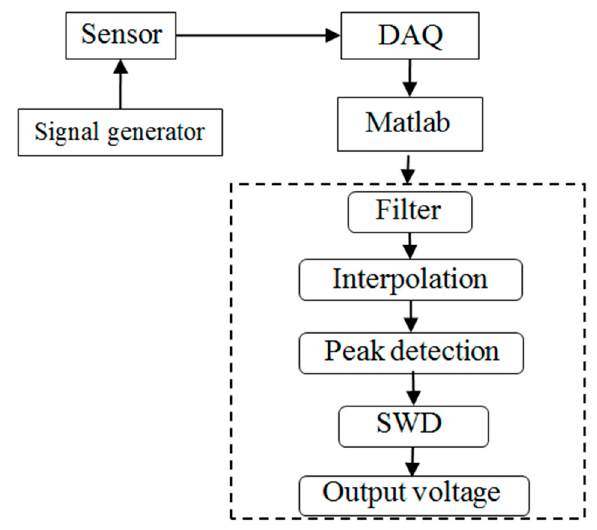
Figure 5. Data processing process. SWD: stationary wavelet decomposition. DAQ: data acquisition.